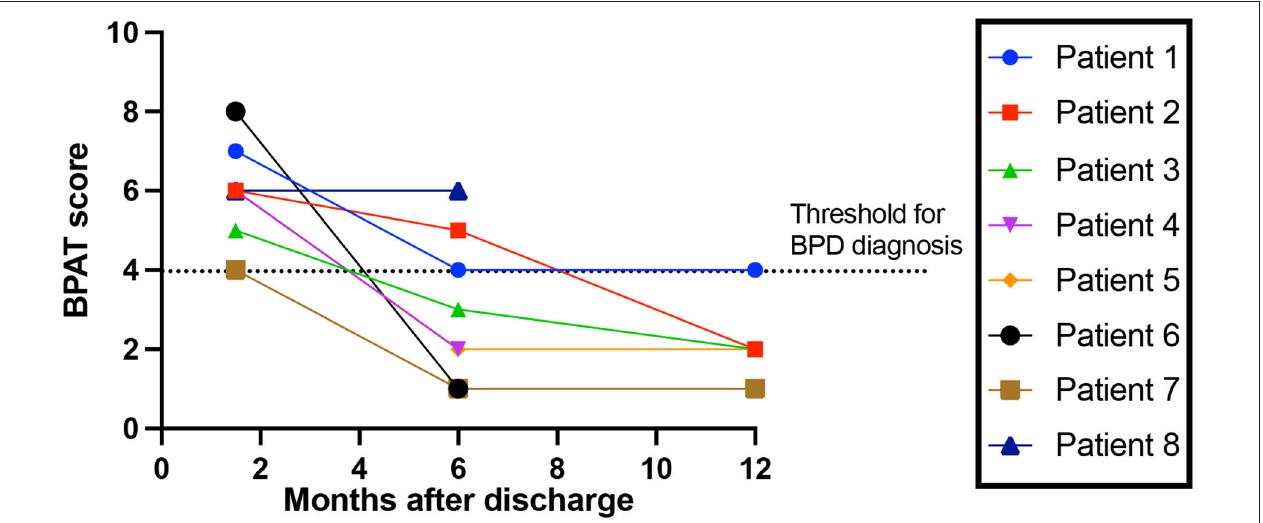
FIGURE 2 | Breathing Pattern Disorder severity over time. Breathing Pattern Assessment Tool score to rate breathing pattern disorder (BPD) severity, over time since discharge from hospital. Threshold for BPD diagnosis is a score of 4 or more ( 16).